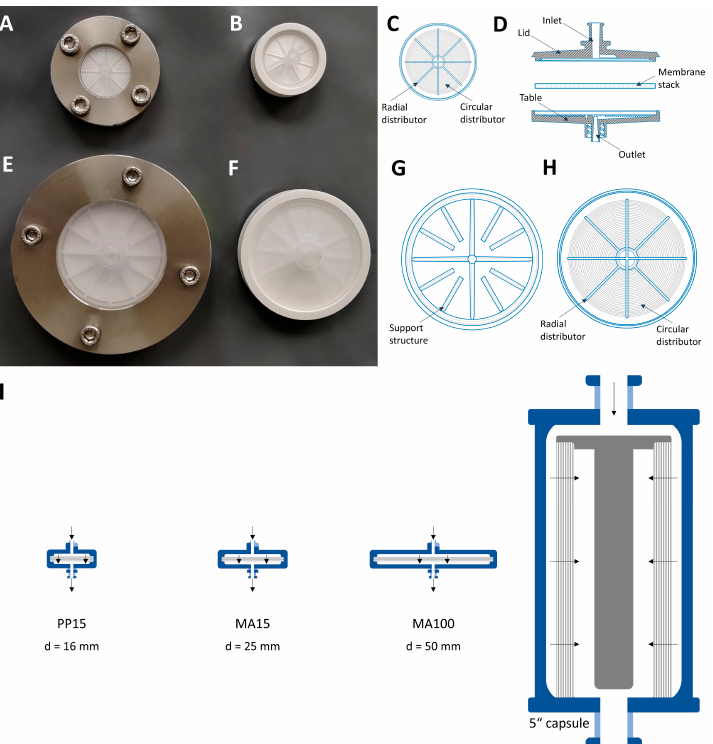
Figure 1. SXC membrane devices. MA15 in a ( A ) stainless-steel holder or ( B ) overmolded. ( C ) The inner structure of the MA15 lid and table with radial and circular distribution channels and ( D ) a cross-sectional view of an SXC membrane device. MA100 in a ( E ) stainless-steel holder or ( F ) overmolded. ( G ) Inner support geometry of the MA100 lid and ( H ) structure of the MA100 table with radial and circular distribution channels. ( I ) Device size comparison of the scale-up approach of SXC using 4 different